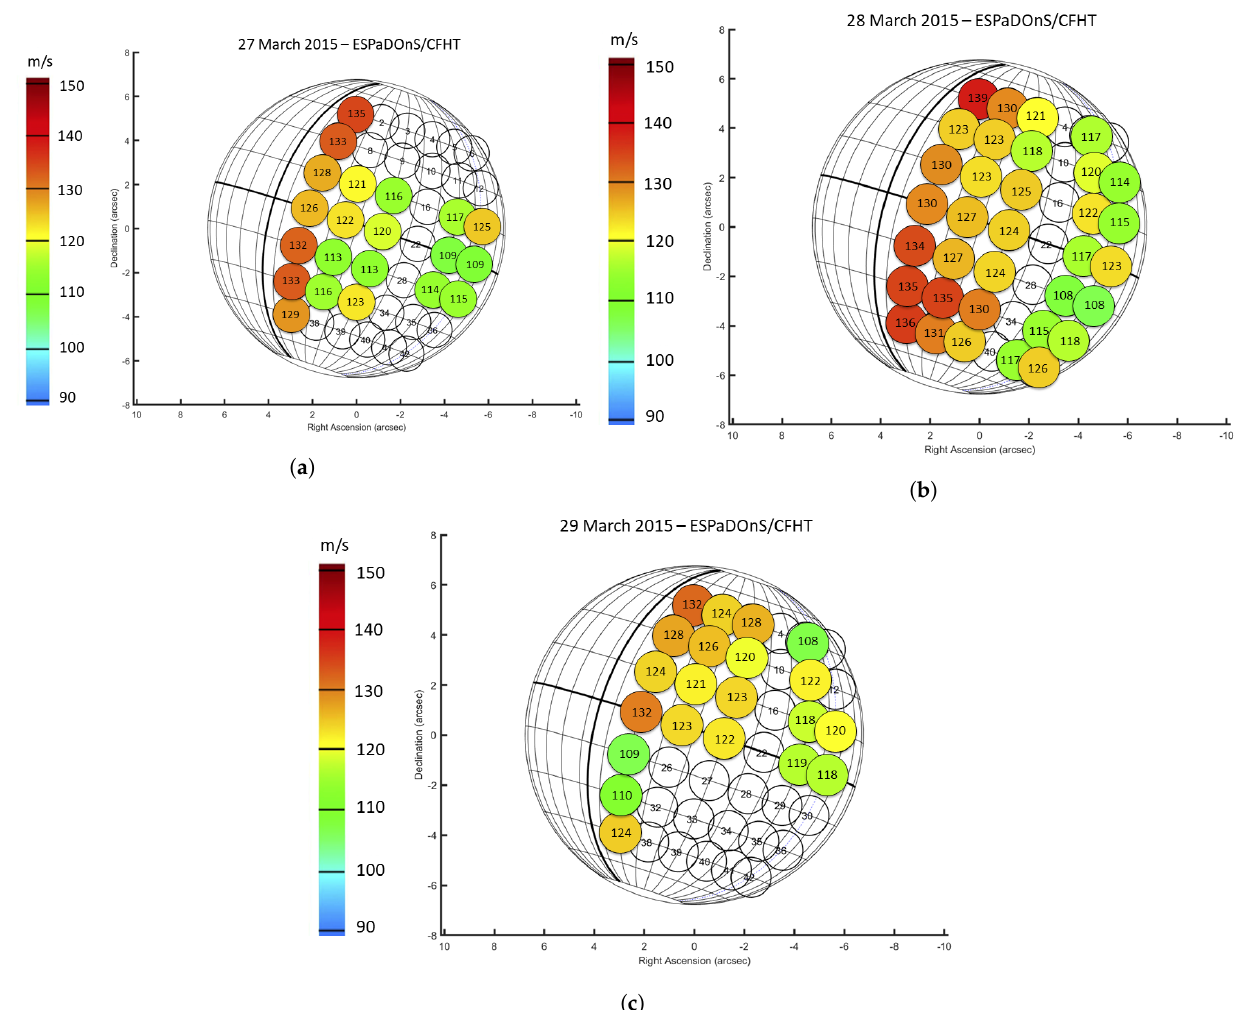
Figure 3. Colour plots of zonal wind for each position observed (as in Figure 1) between 27 and 29 March 2015 (panels ( a – c ), respectively). Zonal wind velocity represented as a color code in a westward direction. The zonal wind velocity is displayed in each FOV, in m/s rounded to unity. The reference point (22) value represents the background wind velocity measured for each day. The zonal wind velocities of all the points located at the half-phase angle (HPA) were retrieved as fluctuations regarding the reference background